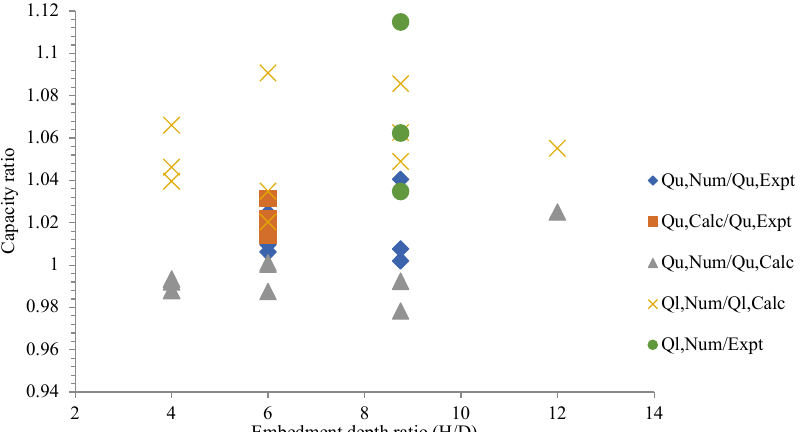
Figure 14. Capacity ratio vs. Embedment depth ratio.